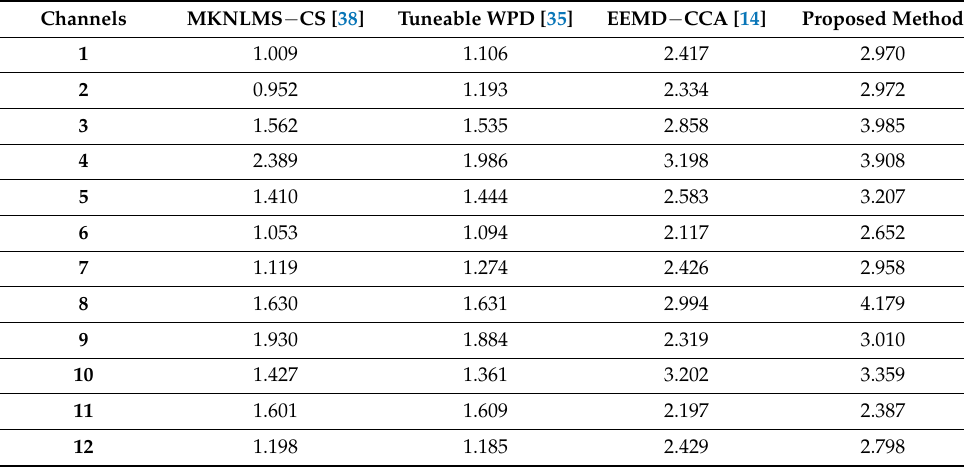
Table 8. Performance comparison on simulated C-EEG. Table 9. Comparison of MI on 32-channel recorded real EEG